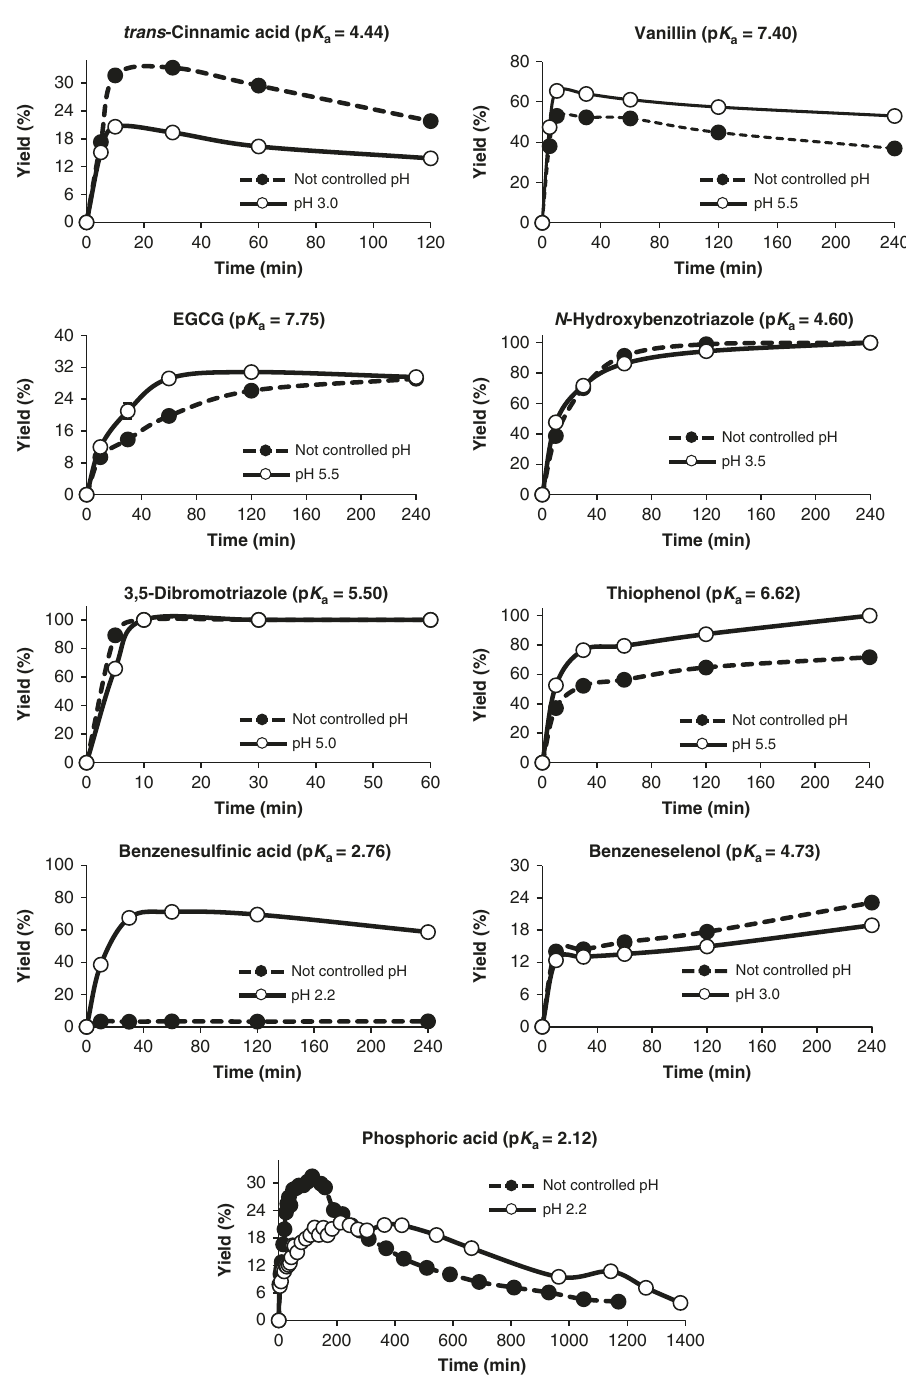
Fig. 5 Production of different xylosides with and without pH control. The plots present the acceptor conversion (%) over time, determined by HPLC, using a 2/1 (mole/mole) donor/acceptor balance for every acceptor, except for phosphoric acid. The latter was analyzed by NMR and yield was calculated in terms of donor conversion (%) using a 1/2 (mole/mole) donor/acceptor balance. Yield pro fi les are represented by a dashed line and black circles for non-controlled pH and by a continuous line and white circles for controlled pH. Mean values are shown together with the corresponding standard error ( n = 3 independent experiments) for every acceptor except phosphoric acid. Formation of the xylosyl phosphoester was assayed with a single replicate by continuously measuring the corresponding sample over time. However, due to the testing of multiple timepoints and two different conditions, results are still signi fi cant to verify the formation and subsequent consumption of the product. Source data are provided as a Source Data fi